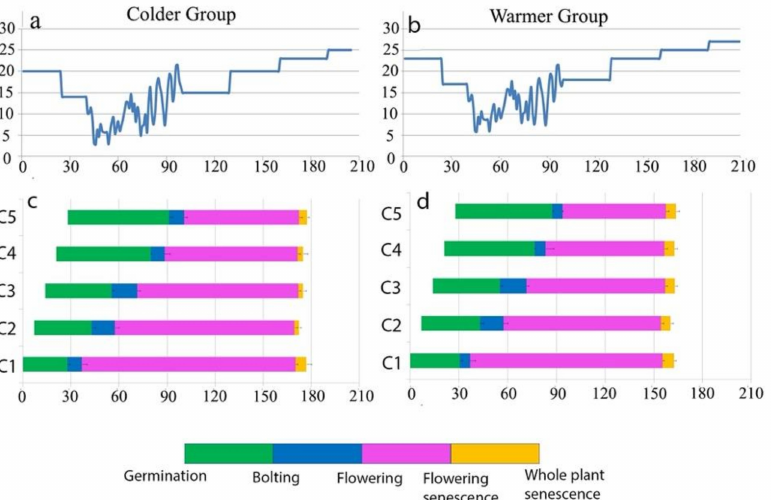
Figure 1. Results of Sequential Seeding Experiment (SSE) for Cvi accession of A. thaliana . Phenological responses of the five cohorts (C1–C5) in Colder Group ( c ) and Warmer Group ( d ) are indicated by bars representing the periods between germination and the four successive reproductive timings. Colors correspond to those in the bar at the bottom of the figure. The x -axis shows the calendar date (number of days since germination). The y -axis in the top panels show the temperature for Colder Group ( a ) and Warmer Group ( b ), and the y axis in the bottom panels refer to cohort number 1–5 (C1–C5). This figure is visualizing 5 cohorts of A. thaliana (Cvi) which are each one week older than the next one that were divided to grow in two different temperature regimes. Colder group (left) lived about a month longer than warmer group and yet the cohorts within each group synchronized senescence timing with each other and not with their same age replicates in the other group. This emphasizes the role of environmental condition on senescence timing (Adopted from Miryeganeh 2020